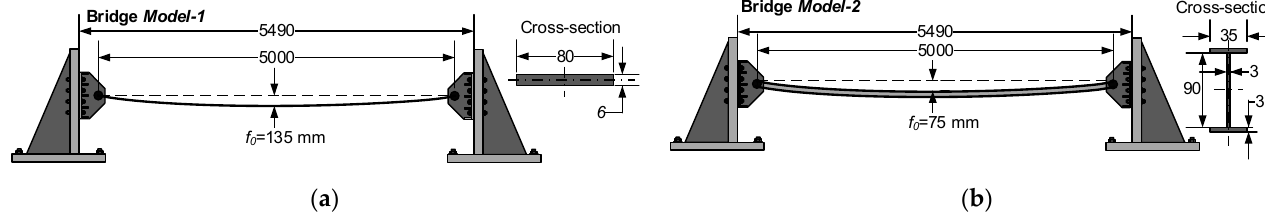
Figure 2. Geometry characteristics of the prototypes with different flexural stiffness of stress-ribbons: ( a ) the bridge with flexible bands; ( b ) the bridge with flexural-stiff ribbon-profiles.